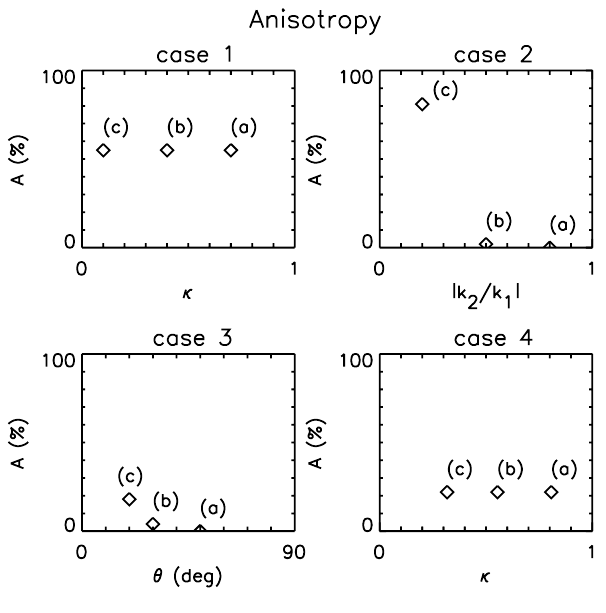
Fig. 11. Anisotropy parameter as a function of the closeness κ of the spectral peak to the boundary of the Brillouin zone measured at k = 0 . 0060 km − 1 from the spectral peak (case 1), the ratio of the two reciprocal vector magnitudes at k = 0 . 0024 km − 1 (case 2), the angle between the two reciprocal vectors at k = 0 . 0022 km − 1 (case 3), and the peak-boundary closeness κ at k = 0 . 0036 km − 1 (case 4).